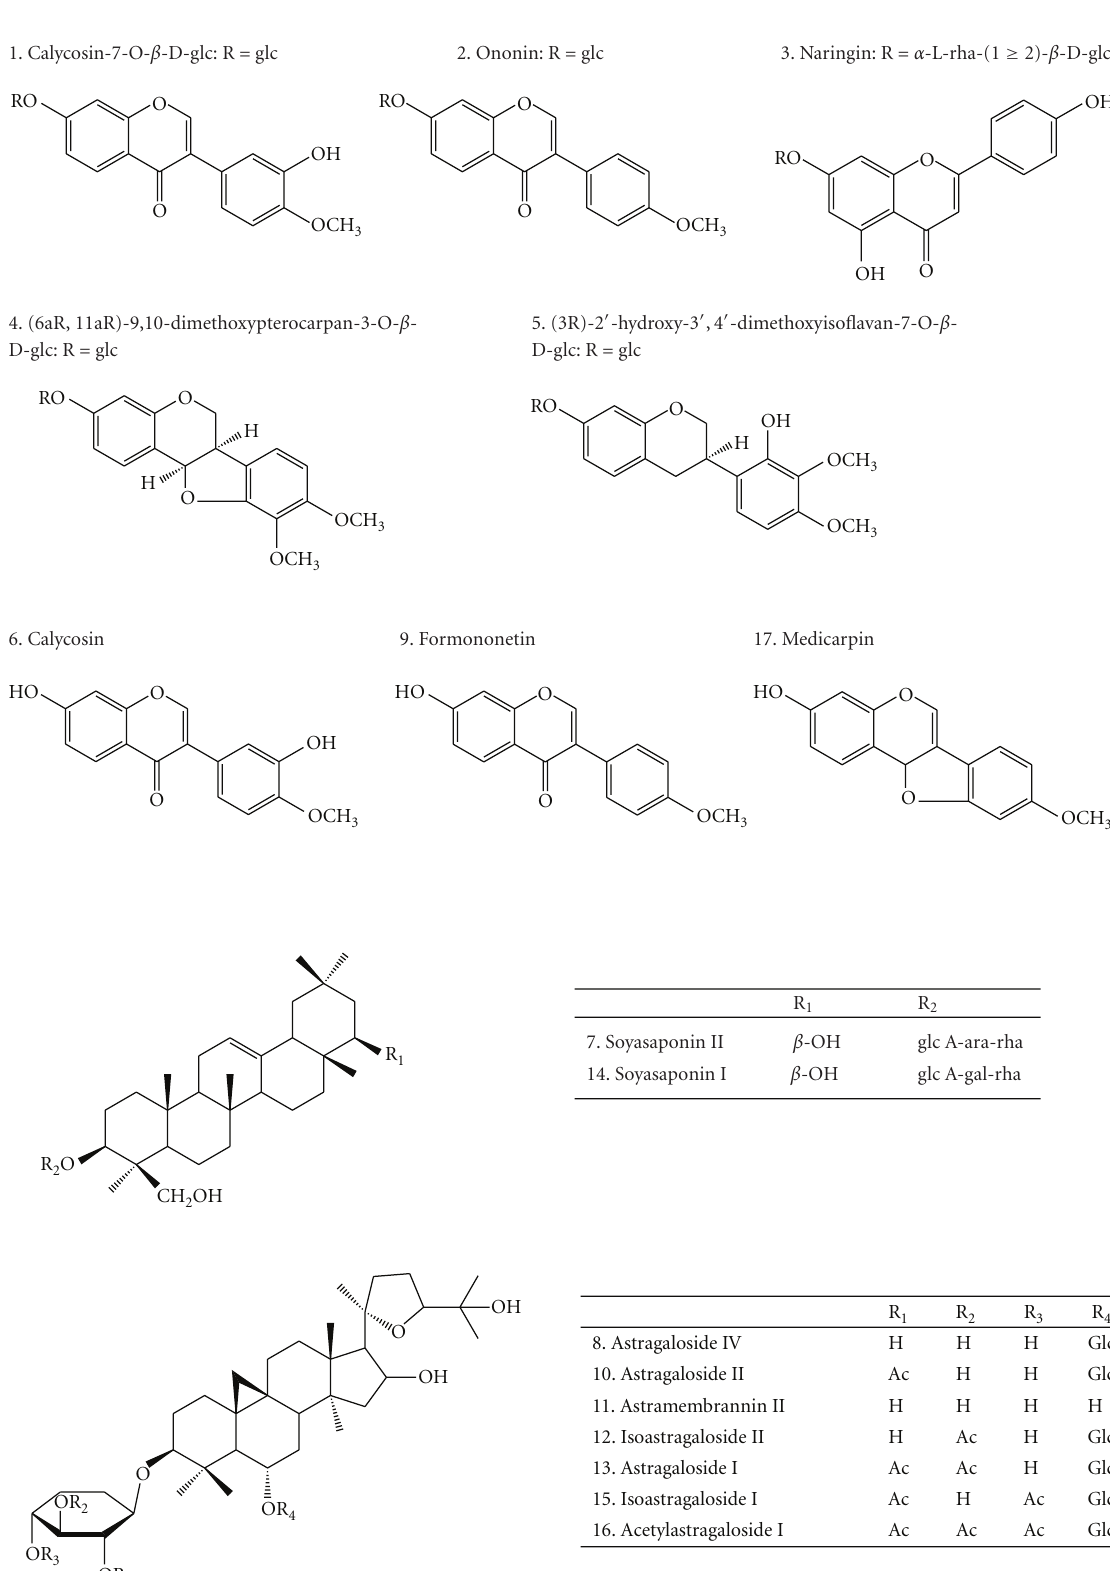
Figure 2: Chemical structures of the compounds identified in the UPLC